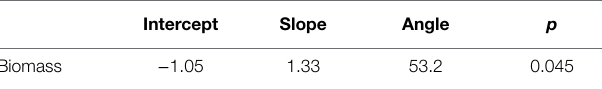
TABLE 4 | Epichloë prevalence was associated with greater final aboveground biomass of the host population.